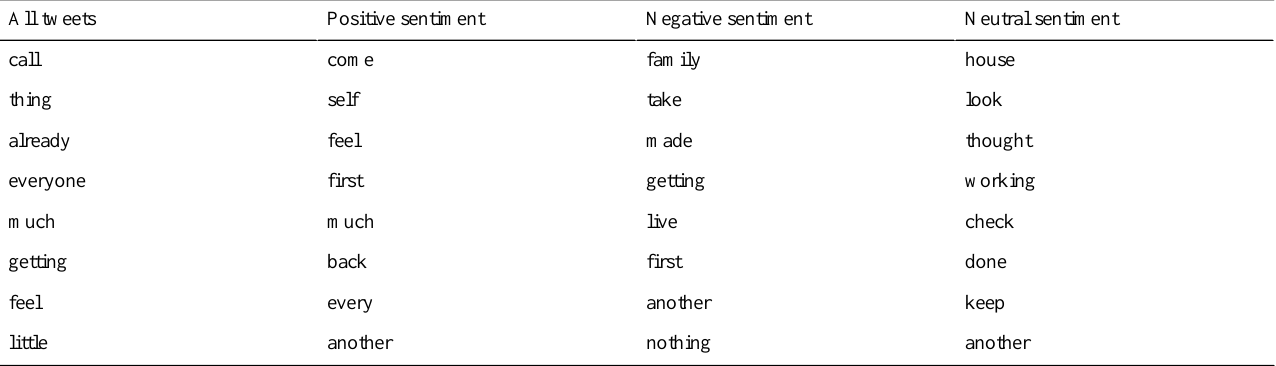
Negative sentimentsNeutral sentimentsPositive sentiments